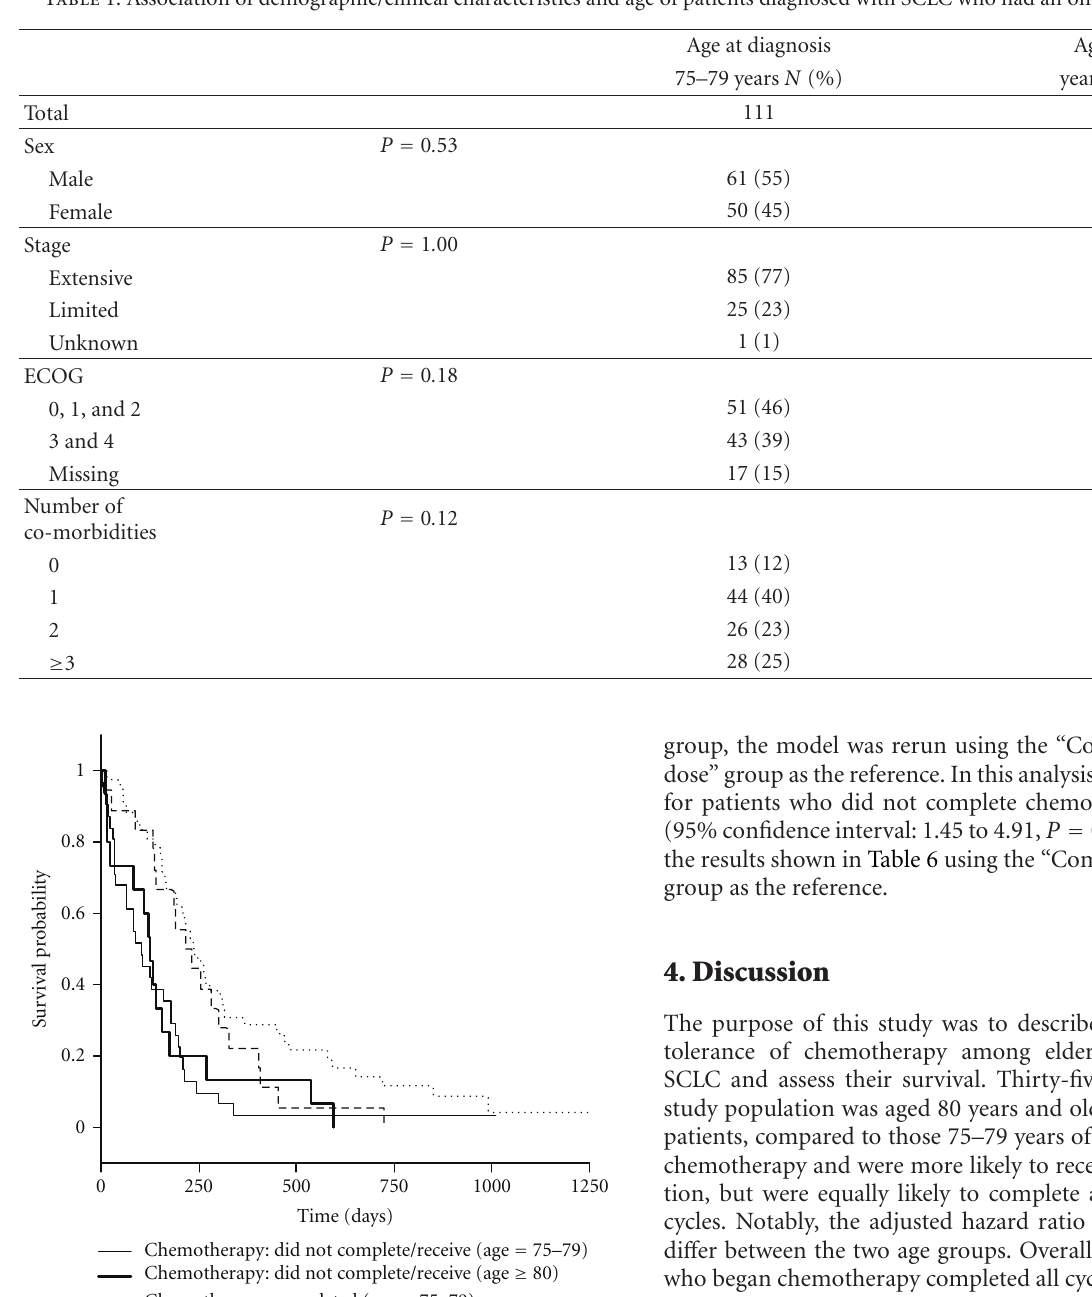
Table 1: Association of demographic/clinical characteristics and age of patients diagnosed with SCLC who had an oncologist-consult.